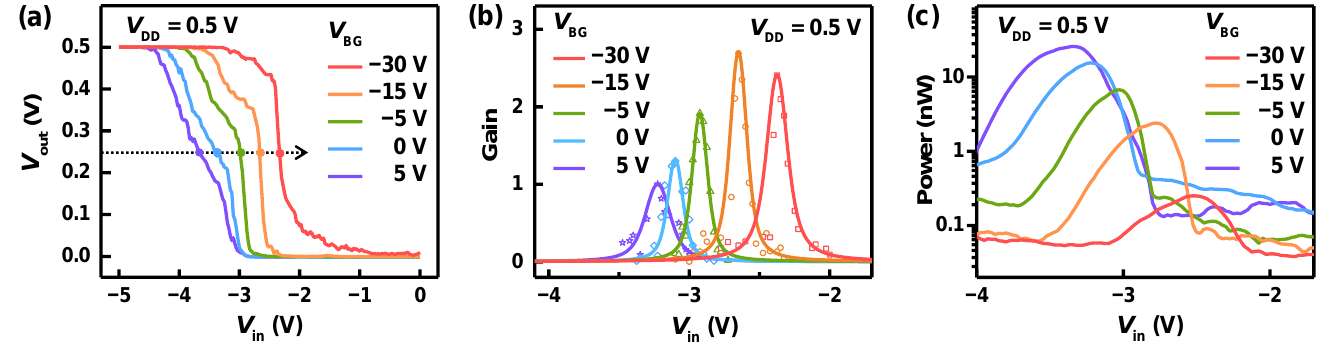
Figure 3. Inverter characteristics modulated with back-gate voltage V BG . ( a ) Voltage transfer charac- teristics of the complementary inverter at V DD = 0.5 V, obtained by varying V BG . ( b ) Voltage gain as a function of the input voltage V in , measured at different V BG . ( c ) Power consumption of the inverter versus V in . Peak power is reduced down to 0.2 nW at V BG = − 30